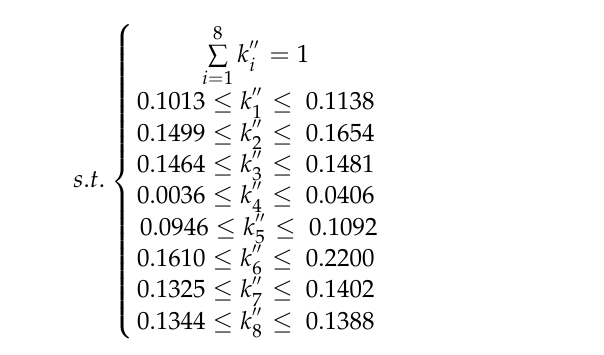
Table 11. Final scores and rankings of alternatives. A 1 0.1138 6